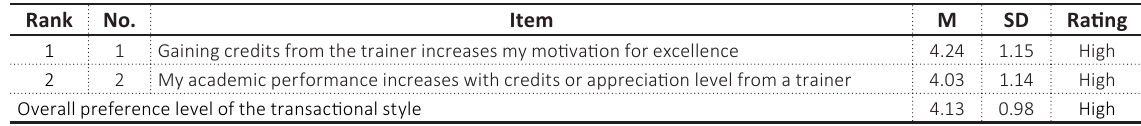
Table 10. Means and standard deviations of respondent responses to items measuring the transactional style in descending order of